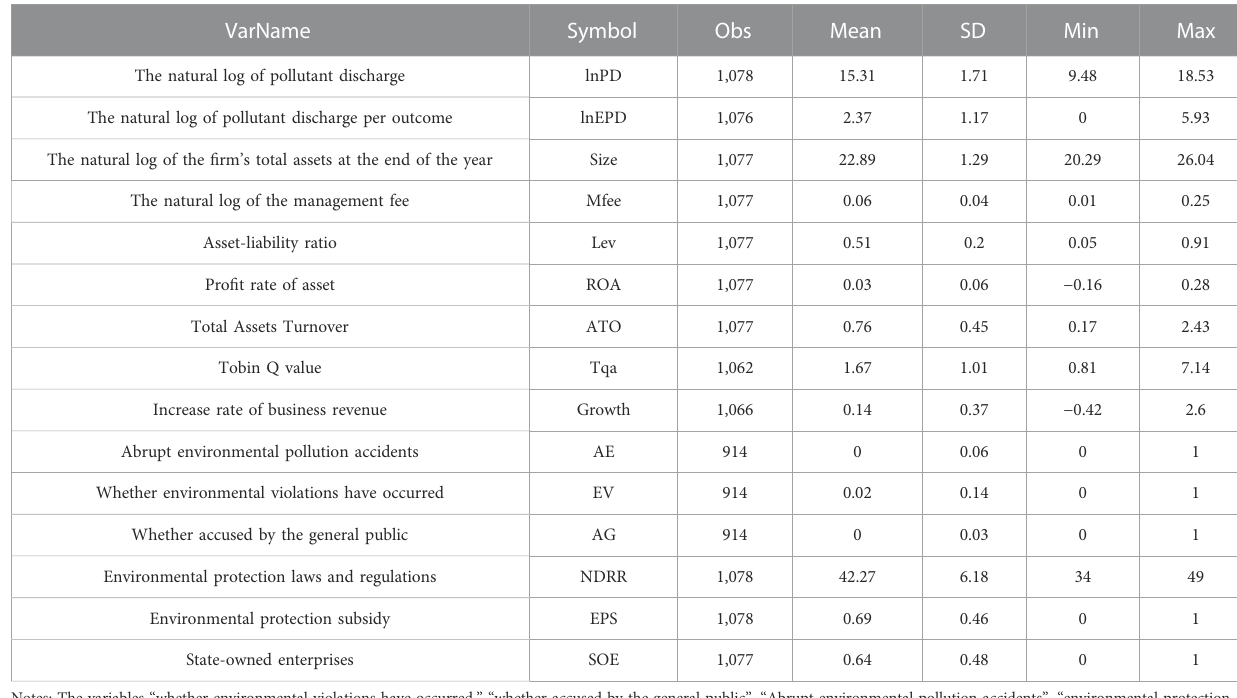
TABLE 1 Descriptive statistics.